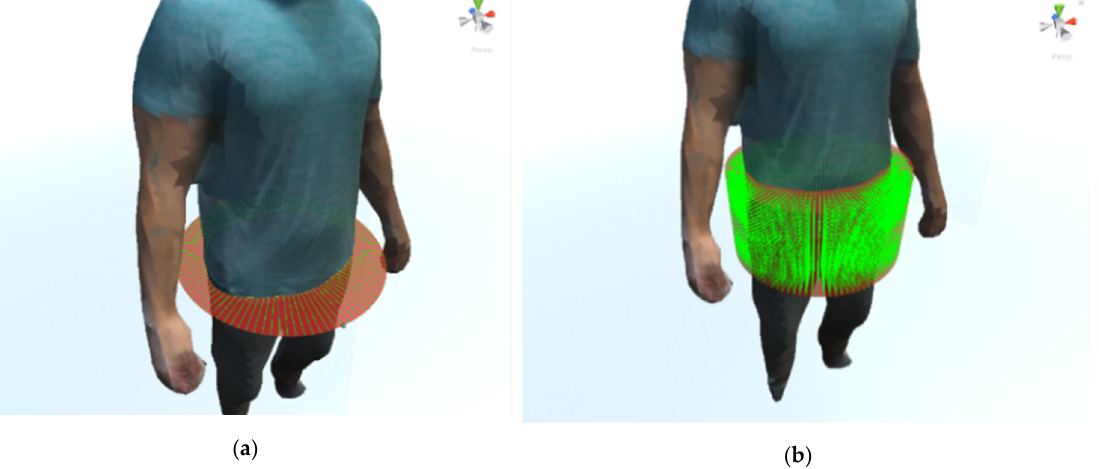
Figure 9. Rays perpendicularly launched along the circumferential chord of the circle storing the points of collision with the mesh ( a ). Rays perpendicularly launched along the circumferential chord of the circles inside the cylinder storing the points of collision with the mesh ( b ).